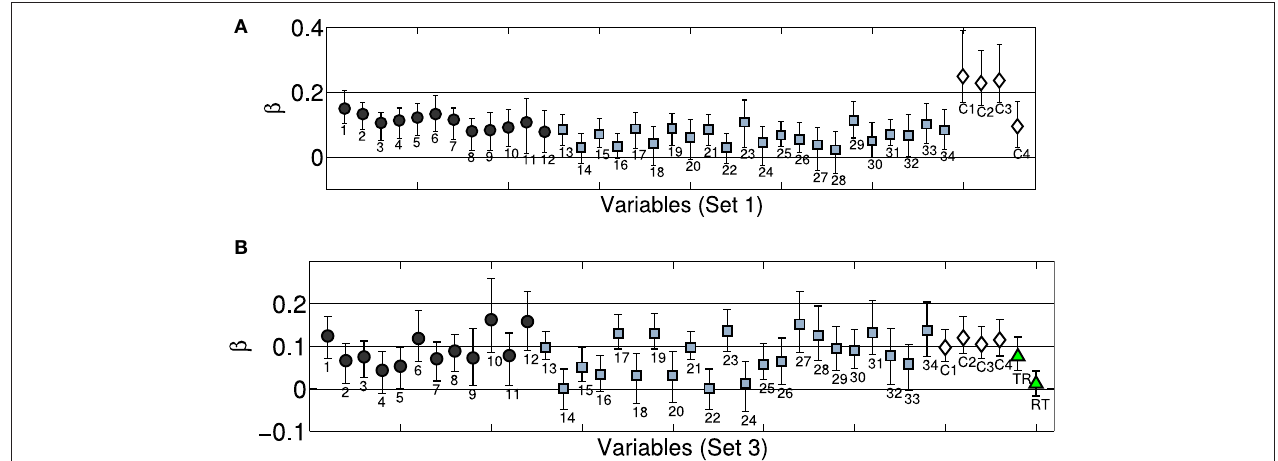
FIGURE 6 | Bootstrapped regression coefficients (standardized) for complete models (acoustic + categorical descriptors) of Set 1 (A) and Set 3 (B, depicts the model that predicts both orders of presentation). (Black) circles correspond to temporal envelope descriptors, (blue) squares to spectral descriptors, (white) diamonds to the four categorical descriptors (within recordings), (green) triangles (Set 3) to across sound category (rec-trans) comparisons. Enumerations of variables corresponds to Table 2 . Categorical variables correspond to (C1) instrument family, (C2) excitation 1 (impulsive, continuous), (C3) excitation 2 (struck, pluck, bowed, blown), and (C4) resonator type (string, air column, bar). RT encode recording-transformation pairs, TR the reverse. Error bars correspond to bootstrapped 95% confidence